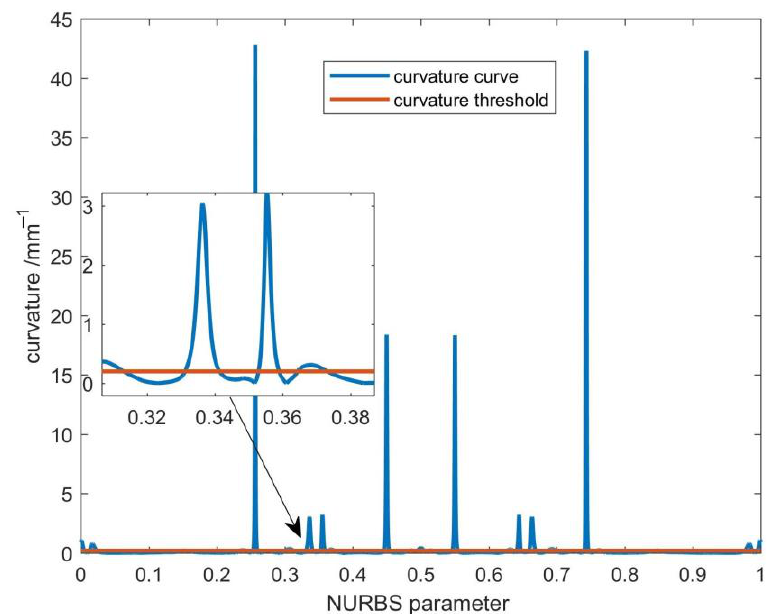
Figure 4. Curvature of the NURBS curve and the curvature threshold.